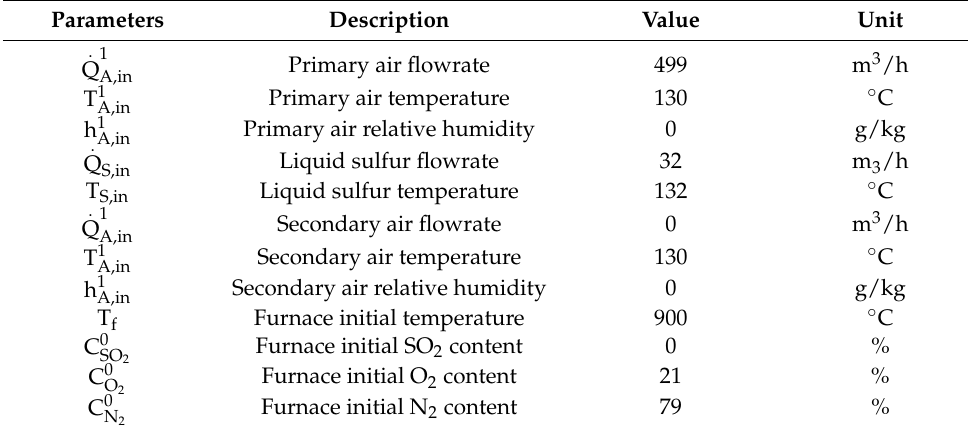
Figure 4. Sulfur combustion furnace simulation using Matlab/Simulink. Table 1. Simulation